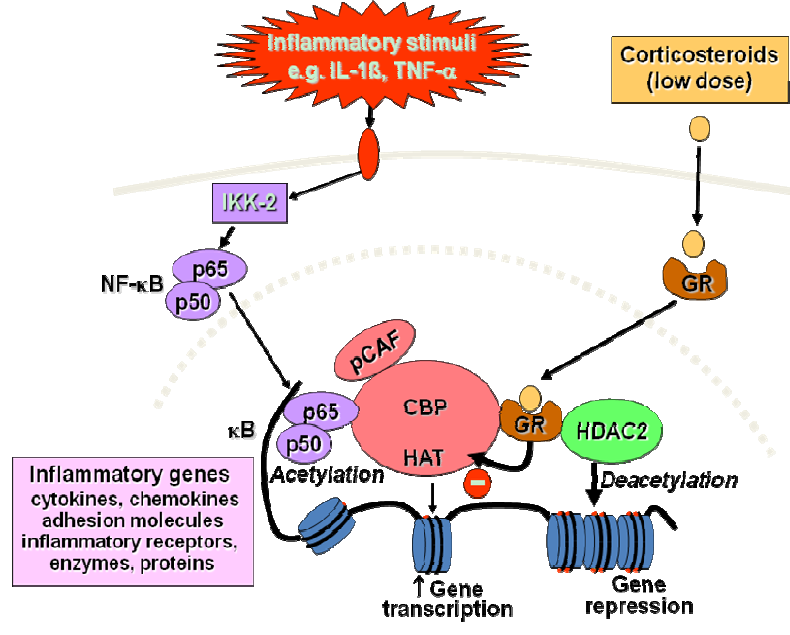
Figure 4. Corticosteroid suppression of activated inflammatory genes. Inflammatory genes are activated by inflammatory stimuli, such as interleukin-1 β (IL-1 β ) or tumour necrosis factor- α (TNF- α ), resulting in activation of IKK2 (inhibitor of I- κ B kinase-2), which activates the transcription factor nuclear factor κ B (NF- κ B). A dimer of p50 and p65 NF- κ B proteins translocates to the nucleus and binds to specific κ B recognition sites and also to coactivators, such as CREB-binding protein (CBP) or p300/CBP-activating factor (pCAF), which have intrinsic histone acetyltransferase (HAT) activity. This results in acetylation of core histone H4, resulting in increased expression of genes encoding multiple inflammatory proteins. Glucocorticoid receptors (GR) after activation by glucocorticoids translocate to the nucleus and bind to coactivators to inhibit HAT activity directly and recruiting histone deacetylase-2 (HDAC2), which reverses histone acetylation leading in suppression of these activated inflammatory